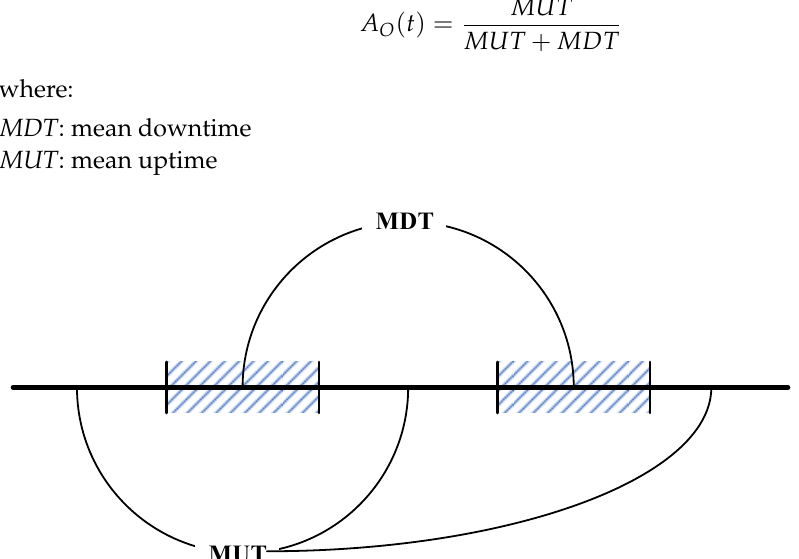
Figure 4. Schematic diagram of availability.